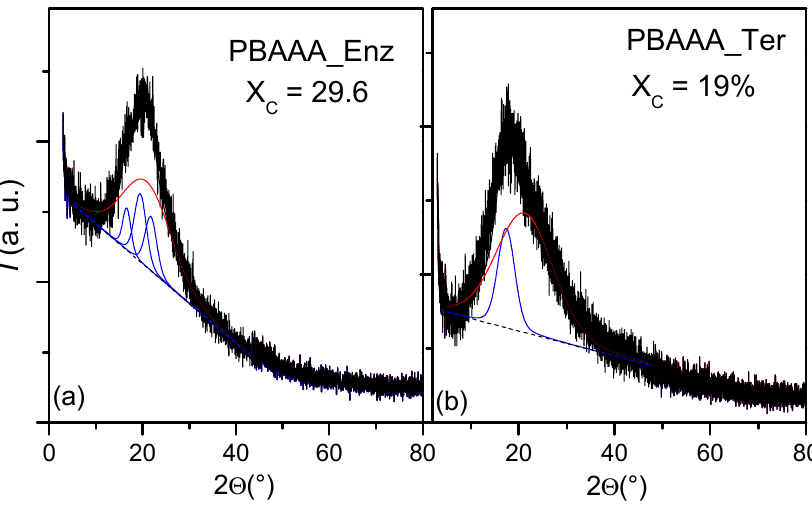
Figure 5. Diffraction pattern of ( a ) PBAAA_Enz and ( b ) PBAAA_Ter . The red line represents the amorphous phase, while the blue lines correspond to crystalline phases present in the sample.